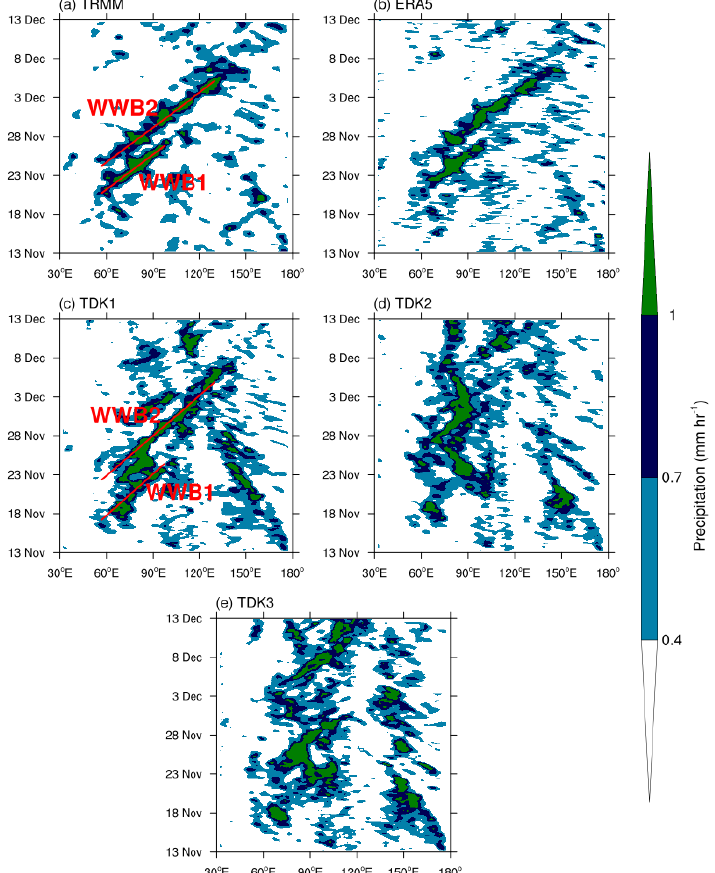
Figure 1. Longitude-time sections of 3-hourly precipitation (mm h − 1 ) derived from ( a ) TRMM satellite observation, ( b ) ERA5, ( c ) TDK1, ( d ) TDK2, and ( e ) TDK3 experiment from 13 November to 12 December 2011. Data are averaged between 10 ◦ N and 10 ◦ S. Red lines represent the first and second precipitation events (i.e., WWB1 and WWB2).